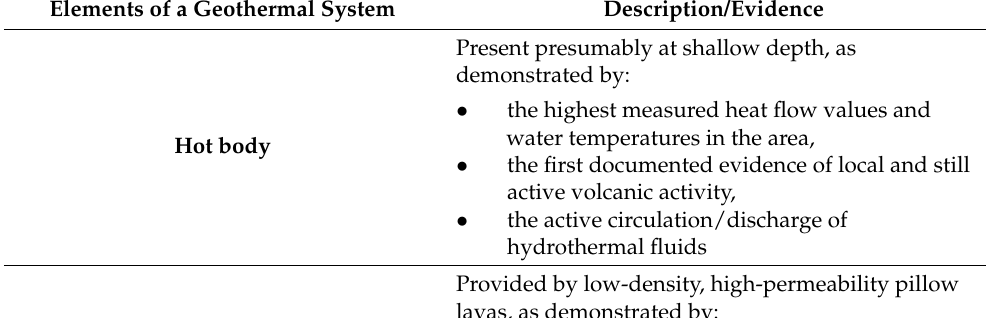
Table 1. Description of the Marsili seamount characteristics as a geothermal